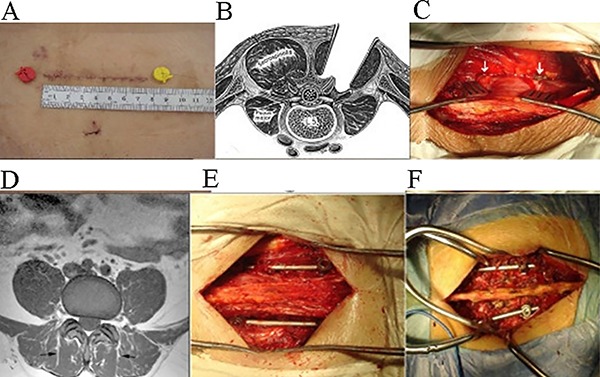
Surgical diagram. A, incision was minimized to 7-8 cm long.
B, initial description by Wiltse of the paraspinal
sacrospinalis-splitting approach to the lumbar spine showing the plane between the
longissimus part and the multifidus part of the sacrospinalis muscle.
C, facet joints are well exposed in the natural cleavage
between the multifidus and the longissimus, which are the entering points of the
pedicle screws. D, MRI shows the natural cleavage between the
multifidus muscles. Paraspinal muscles are left intact in the paraspinal approach
(E) compared with the traditional posterior approach
(F). After surgery using pedicle and rod system internal
fixation by the paraspinal approach, the composite of posterior column was
preserved integrally (E).